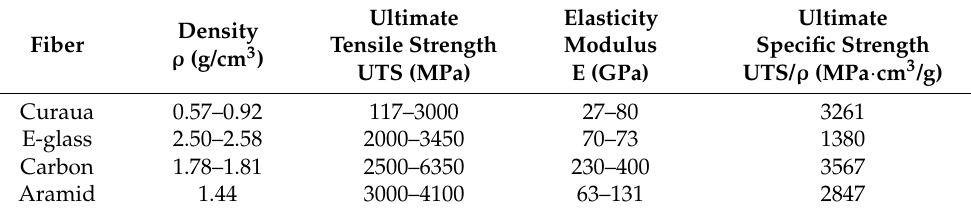
Table 1. Physical and mechanical properties of curaua and synthetic fibers. Adapted with permission from Ref. [16]. Copyright 2015 John Wiley & Sons,